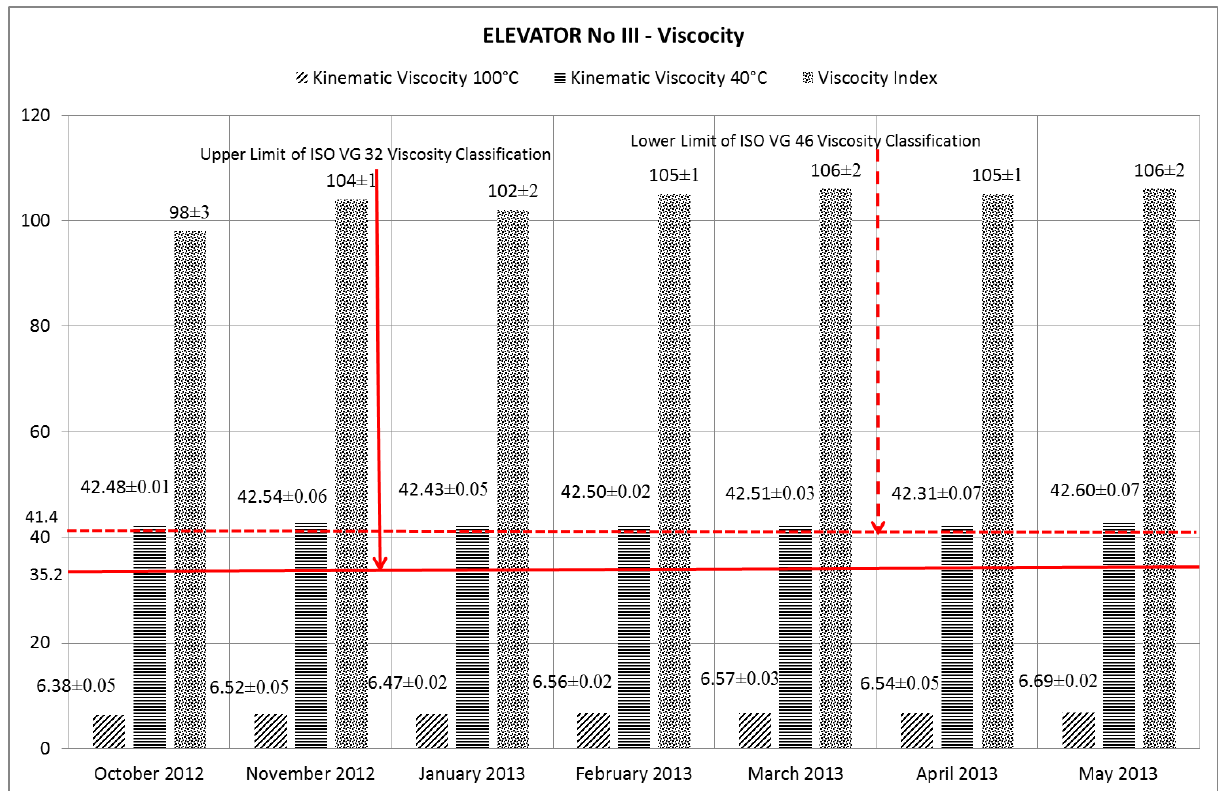
Figure 3. Viscosity in Elevator